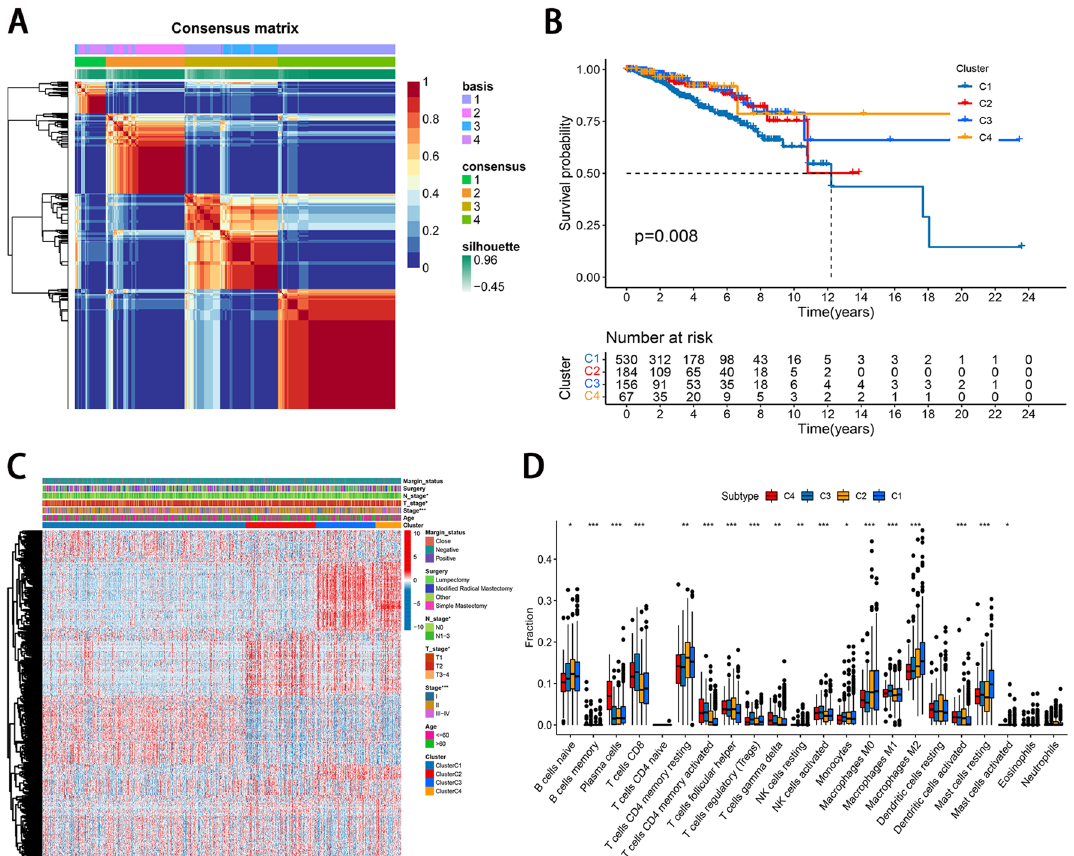
Figure 1. Identification molecular subtypes based on the necroptosis-related lncRNA. ( A ) NMF consensus clustering for the k value was 4. ( B ) Kaplan–Meier curves of OS for patients with the four subtypes. ( C ) Correlation between the four subtypes and TNM stage. ( D ) The enrichment scores of 22 kinds of immune cells across the four